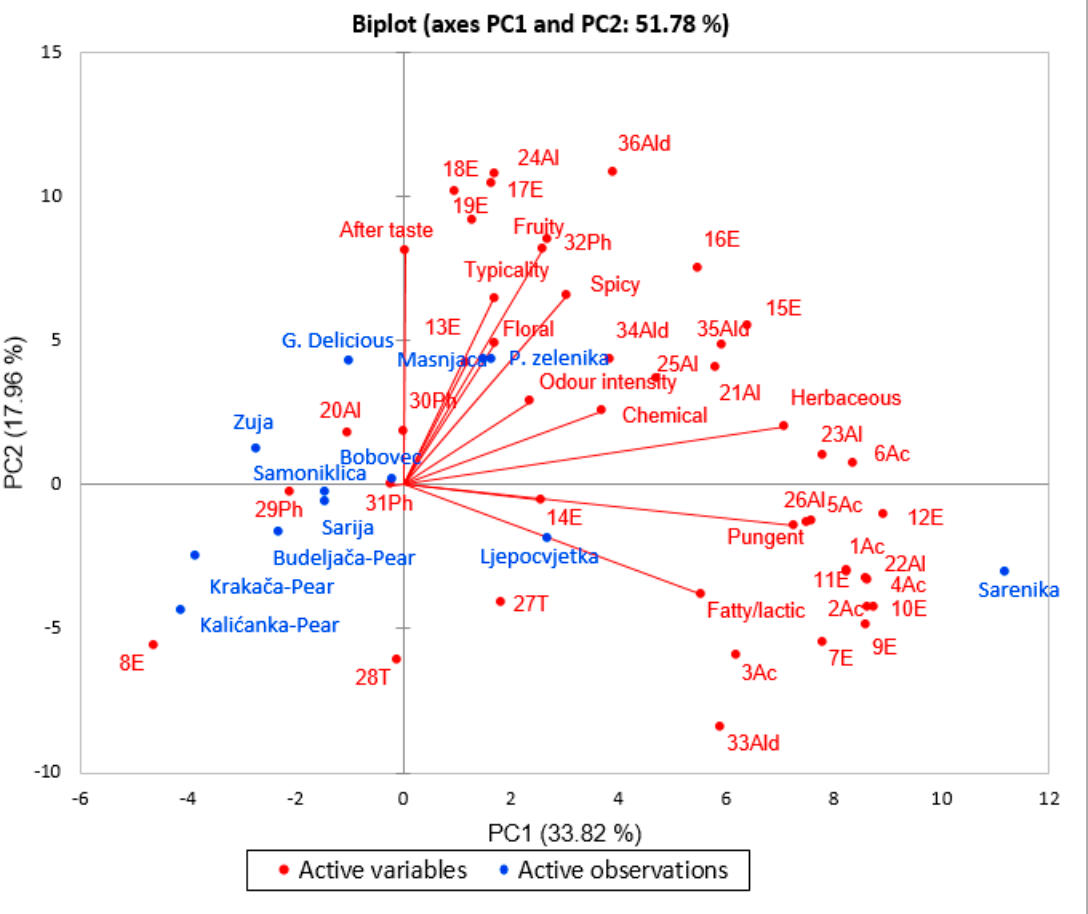
Figure 2. PCA bi ‐ plot for volatile compounds and sensory attributes for 9 apple and 3 pear spirits. 1Ac–Butanoic acid ‐ ;